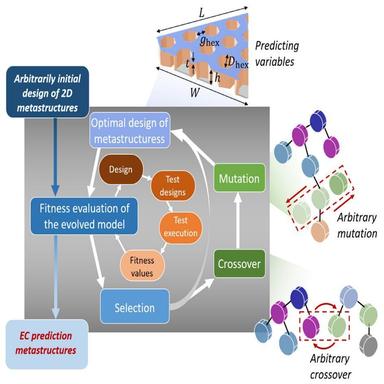
The evolutionary process to characterize and design the plate-like metastructures with corrugation.